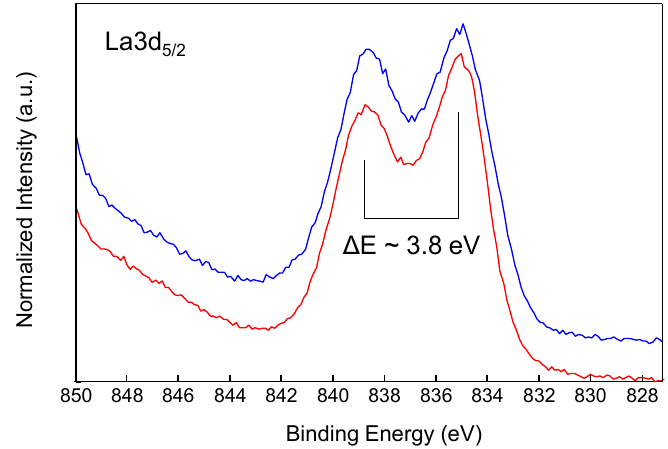
Figure 4. High-resolution La3d 5 / 2 spectra of La(III)O-KIT-6 (red) and La(III)O-KIT-6 after three cycles of reaction (blue).